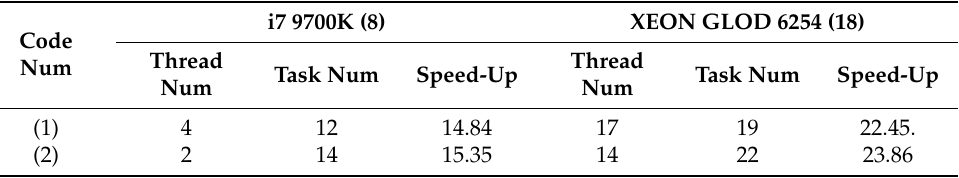
Table 4. Speedup comparison of the adaptive allocation of tasks and threads with manual allocations of threads and tasks on different